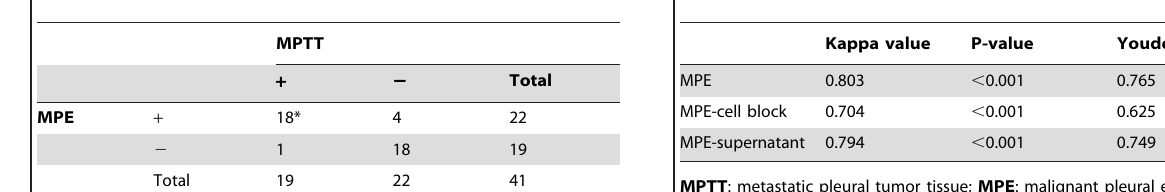
MPTT : metastatic pleural tumor tissue; MPE : malignant pleural effusion; + : EGFR positive-mutation; 2 : EGFR negative-mutation. *: among the 18 patients, one patient showed an exon 19 deletion in MPTT versus S768I mutation in the matched MPE-cell block.